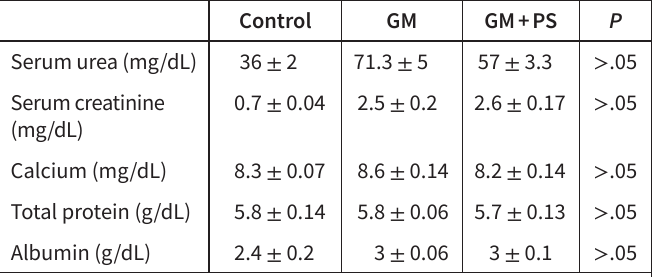
Table 1. The Serum Biochemical Results of the Groups on Day 8.